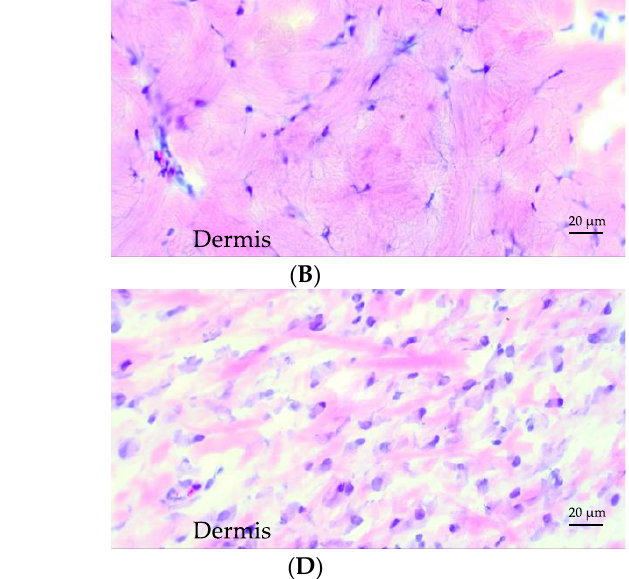
Figure 4. Classical hematoxylin and eosin (H&E) staining of control ( A , B ) and healed ( C , D ) pig skin. The skin surface is directed towards the top/left. The individual epidermal layers can be identified in the control skin labelled ( A ). Magnifications of the dermis part for control and healed skin are provided in ( B , D